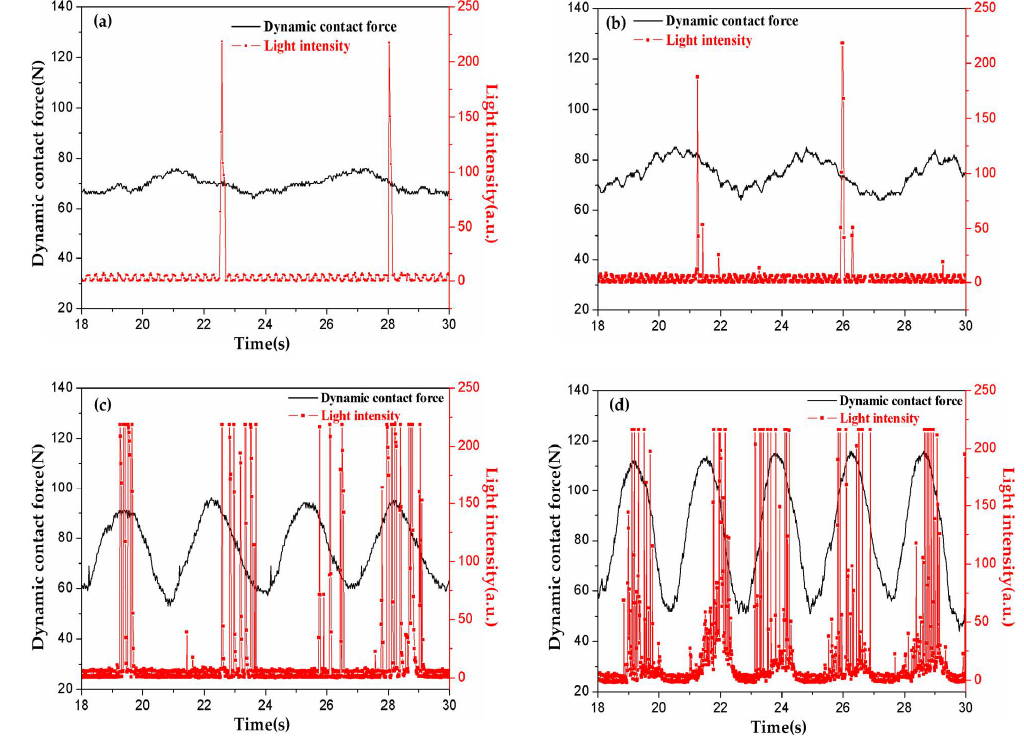
Figure 3. Light intensity varying with velocity: ( a ) 40 km·h −1 ; ( b ) 60 km·h −1 ; ( c ) 80 km·h −1 ; ( d ) 100 km·h −1 .